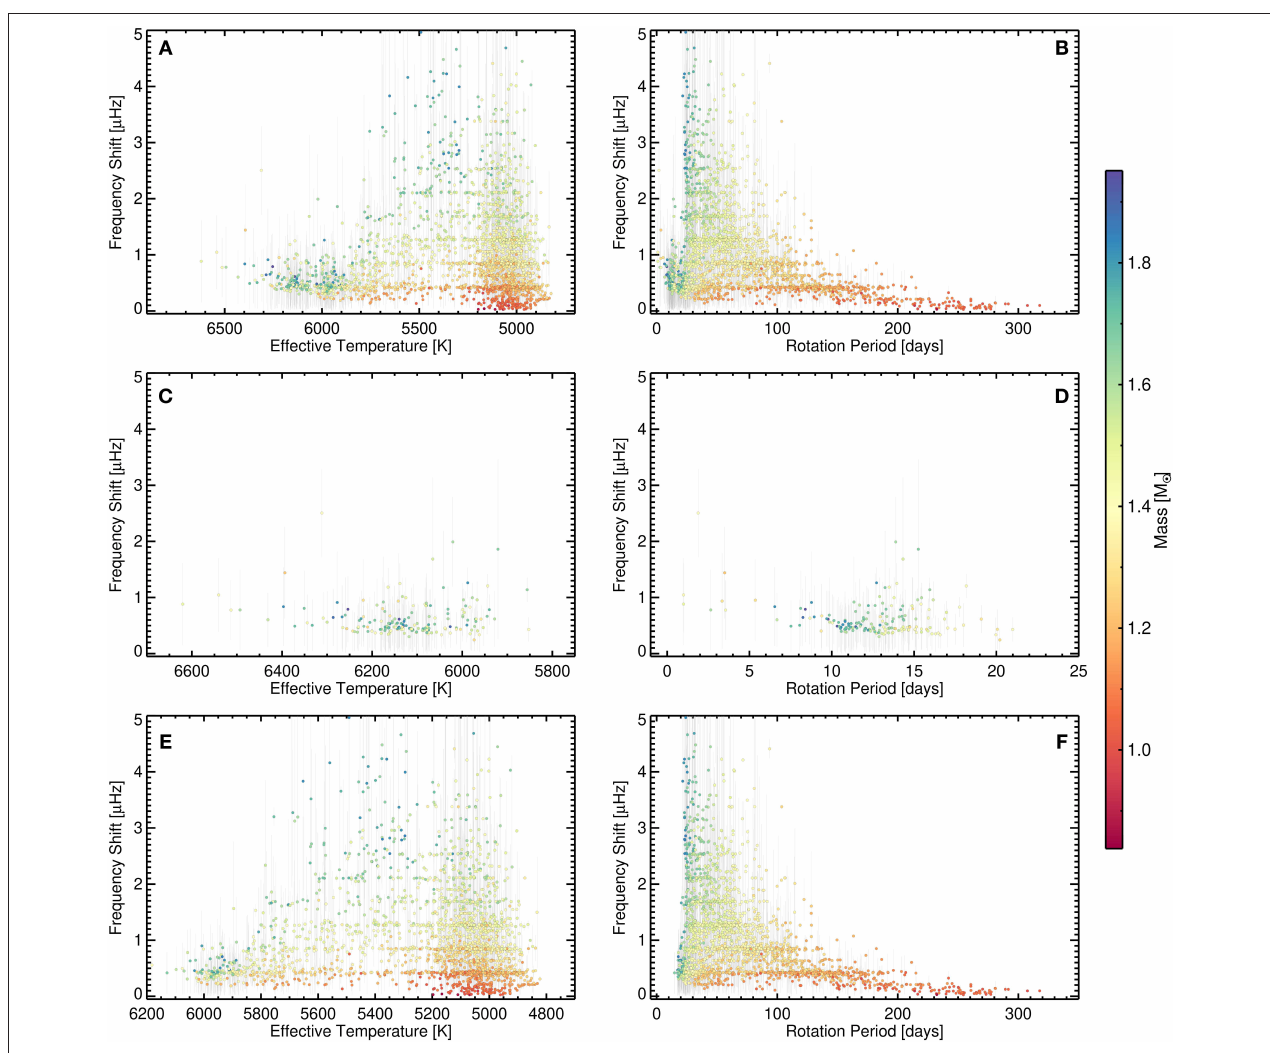
FIGURE 5 | Same as Figure 4 but color coded with stellar